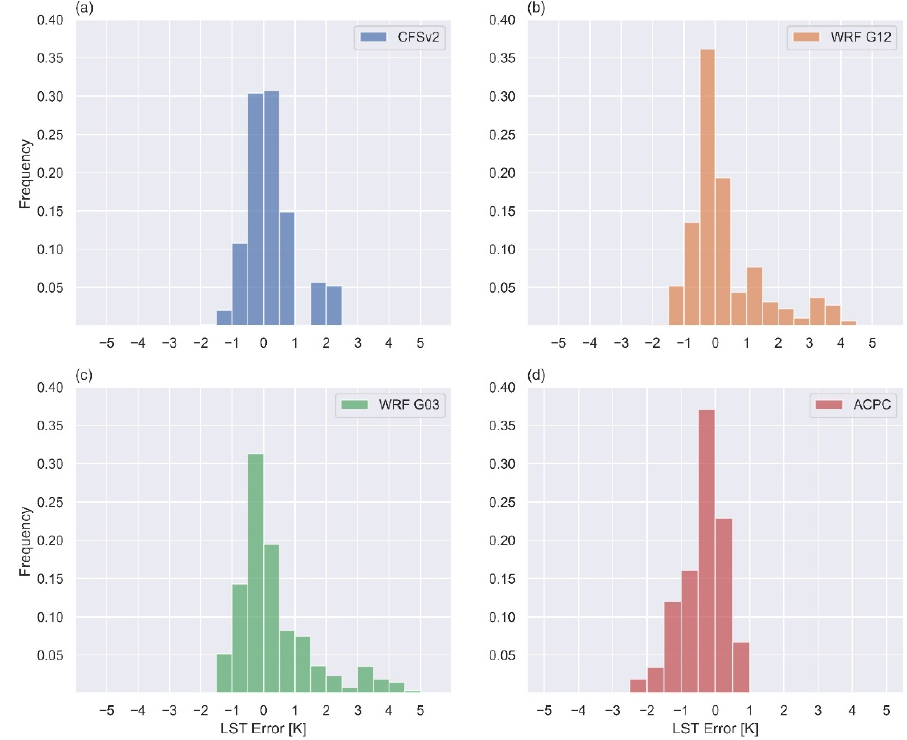
Figure 7. Normalized histograms of the LST errors using profiles from ( a ) CFSv2, ( b ) WRF G12, ( c ) WRF G03, and ( d ) ACPC.